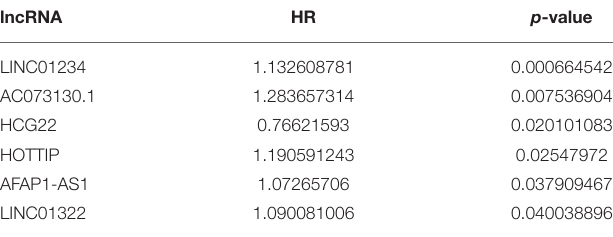
TABLE 7-1 | lncRNA univariate Cox regression results.